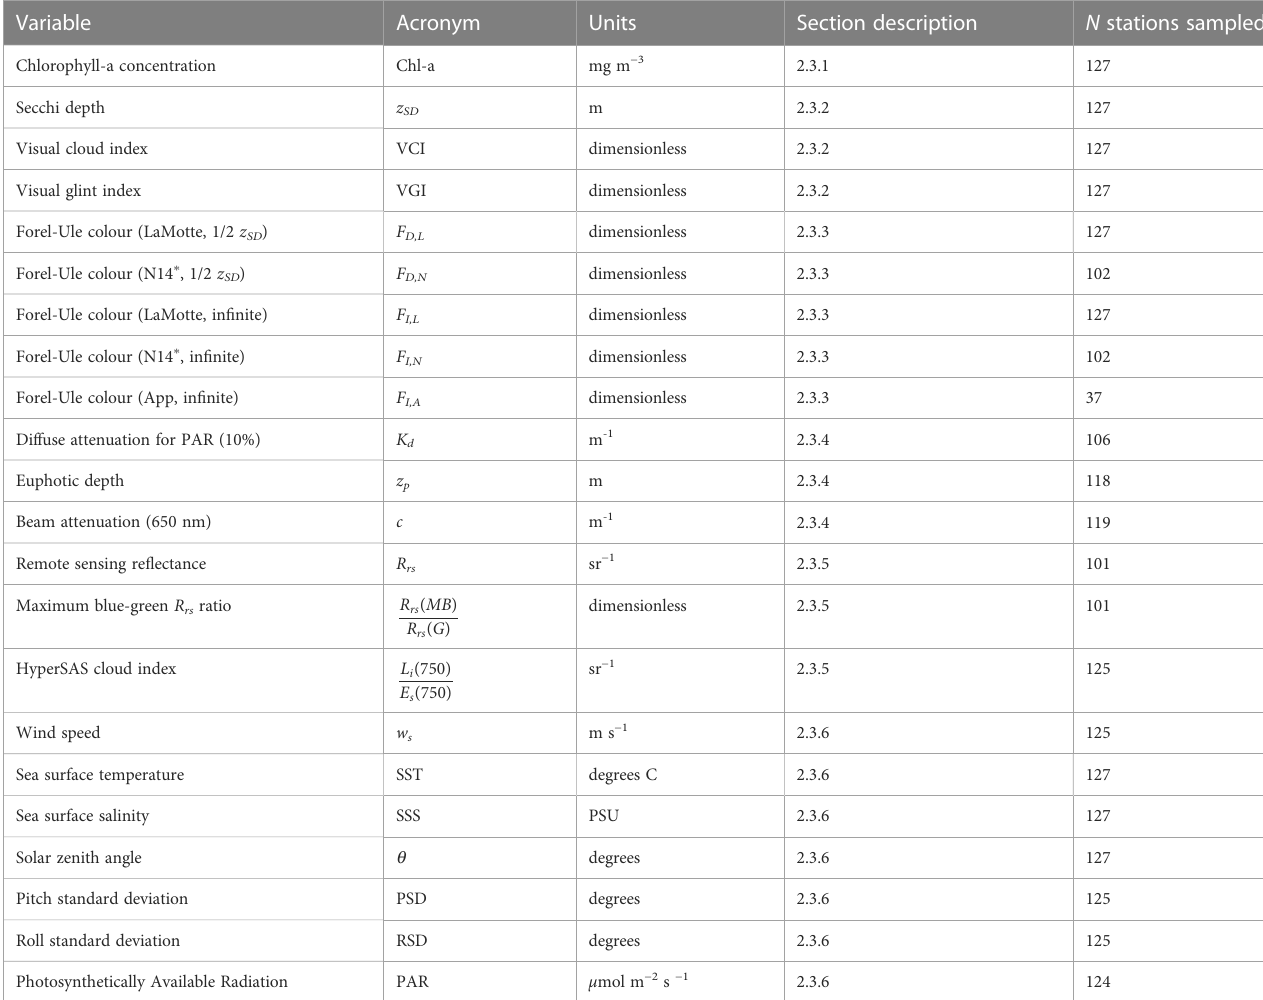
TABLE 1 A summary of the datasets collected and used in the